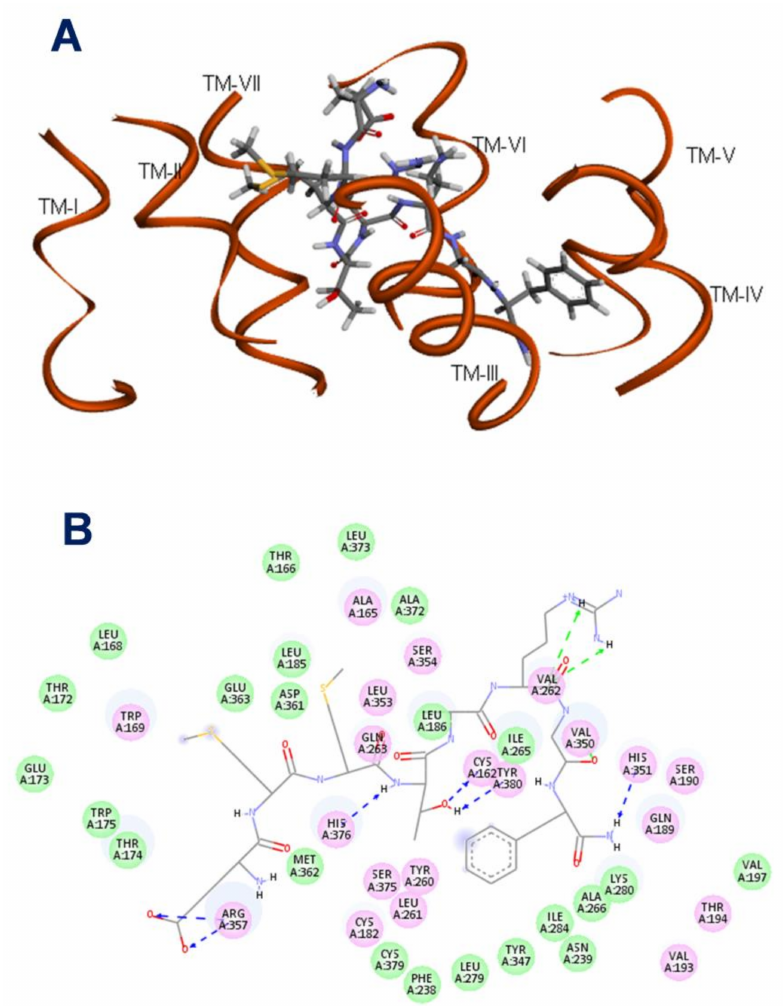
Figure 2. Predicted structure of Manse-ATR binding pocket with Manse-AT (6–13) as ligand. ( A ) Manse-AT (6–13) occupying the binding pocket of Manse-ATR. The putative binding pocket of Manse-ATR was localized between helices II, III, IV, V, VI and VII, ECL2 and ECL3; ( B ) the important residues of the binding pocket. Cys162 (TM-II), Val262 (ECL-2), His351 (TM-VI), Arg357 (TM-VI), His376 (TM-VII) and Tyr380 (TM-VII) of receptor have hydrogen bonding interactions with the residues Glu1, Thr 4 , Arg 6 and C -terminal amide of Manse-AT (6–13). The Phe 8 of Manse-AT (6–13) has a strong hydrophobic interaction with the pocket. This analysis was done by Discovery Studio 3.5